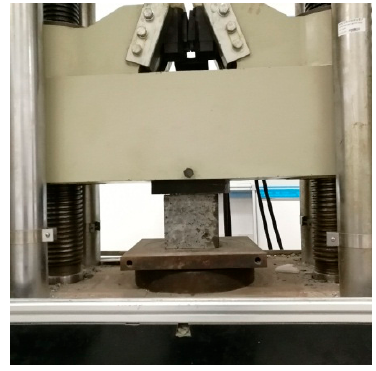
Figure 3. Compression test of concretes.